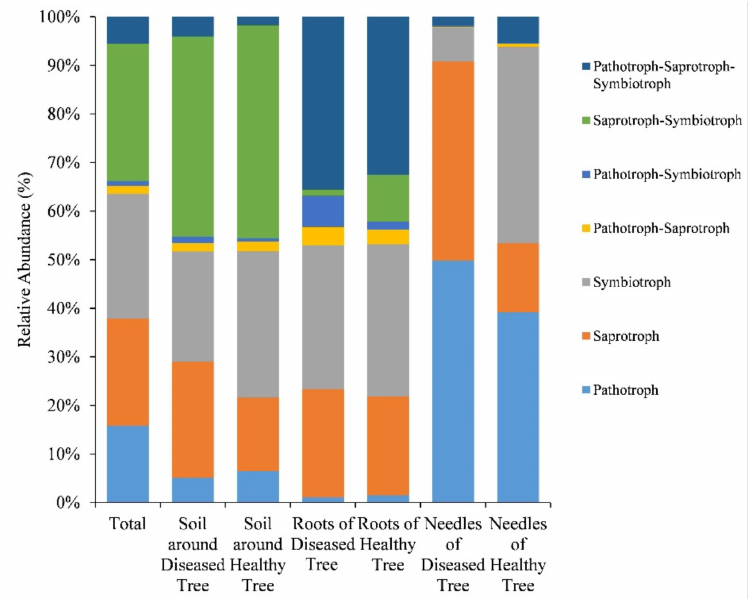
Figure 6. FUNGuild (http://www.states.org/guilds/app.php (accessed on 31/9/2019)) analysis showing predicted trophic mode in soil, roots, and needles around and of healthy and diseased trees.